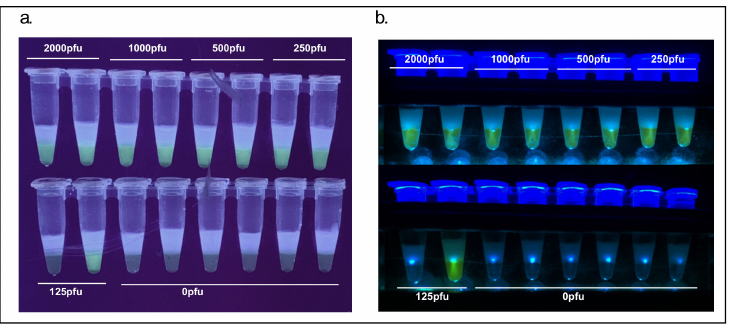
Figure 5. ( a ) Detection of SARS-CoV-2 using proteinase K, magnetic wand extraction and a one-step cartridge, NMT swabs spiked with inactivated SARS-CoV-2; ( b ) same tubes visualized with the GMO